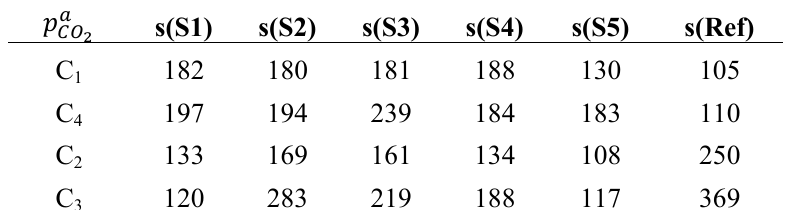
Table 4. Concentration-dependent standard deviations (s [ppm]) for registration of the concentrations C –C (in Figure 3) observed by line-sensors (S1–S5) and the reference 1 4 (Ref). The line-sequence was arranged with respect to increasing concentrations C ≈ C < C < C 1 4 2 3